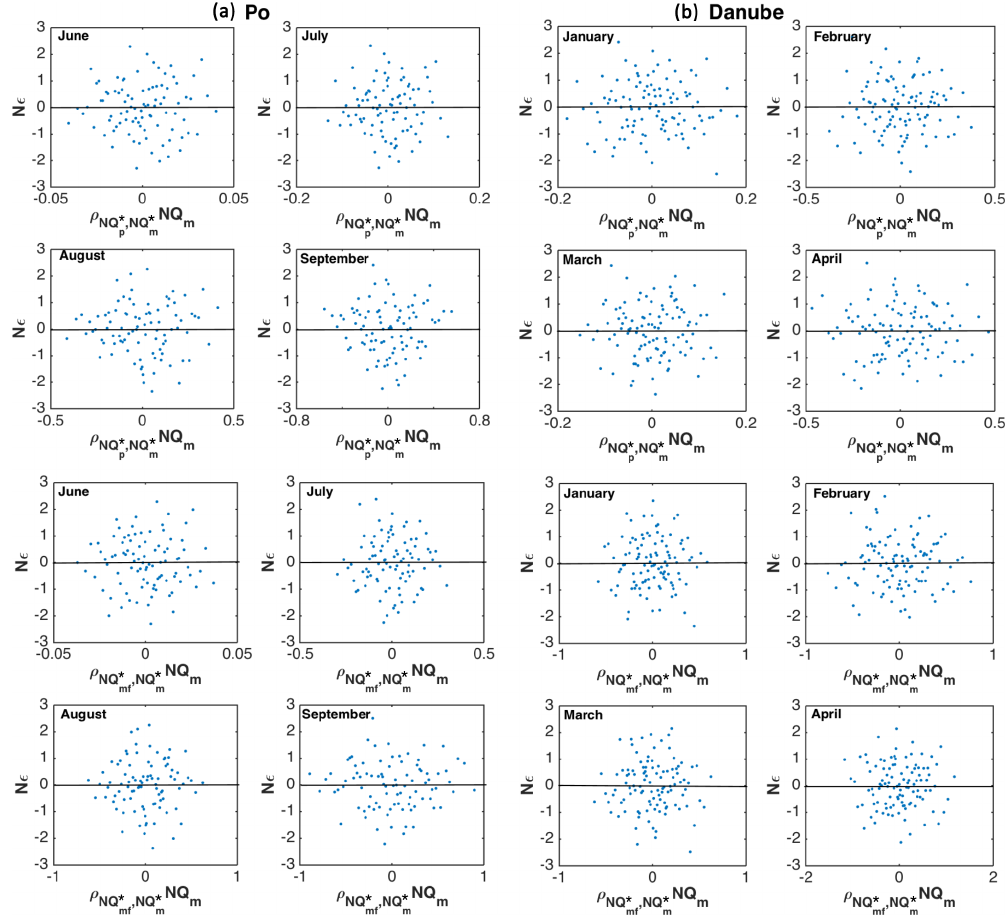
Figure 4. Residual plot of the linear regression of NQ m on NQ p and NQ mf in the Po River (a) and upper Danube (b) .